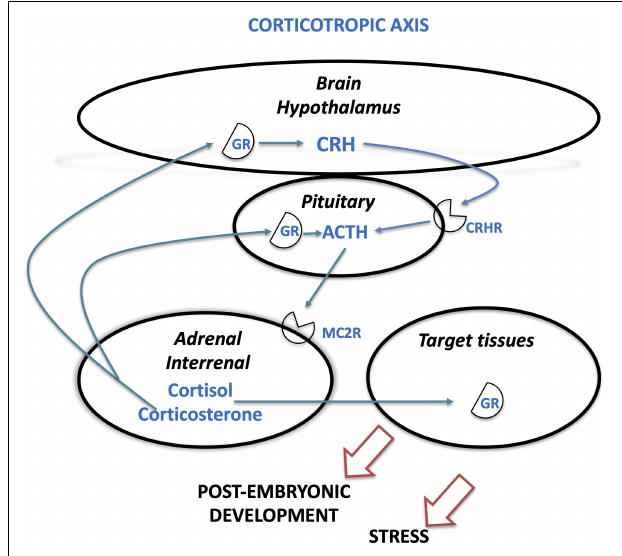
FIGURE 3 | Corticotropic neuroendocrine axis in vertebrates. The figure displays the main actors of the corticotropic (hypothalamic-pituitary-adrenal/interrenal, HPA/HPI) axis. ACTH, adrenocorticotropin; CRH, corticotropin-releasing hormone; CRHR, corticotropin-releasing hormone receptor; GR, glucocorticoid receptor; MC2R, melanocortin receptor